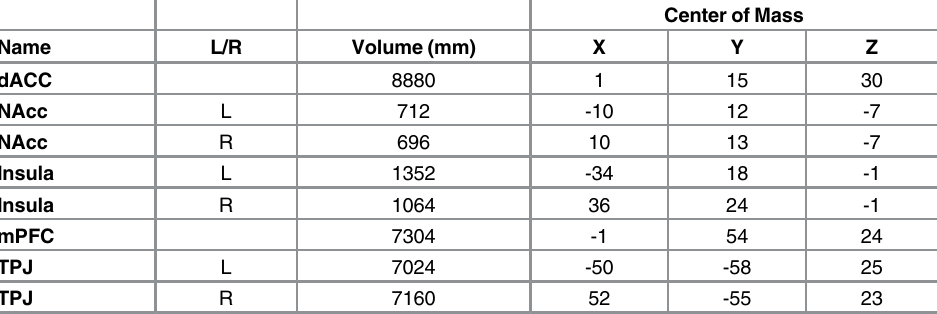
Table 1. Coordinates and volumes of Regions of Interests that were extracted from Neurosynth and anatomical atlases (see text for details).